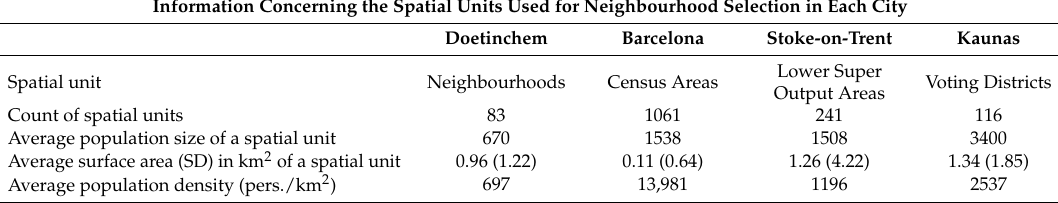
Table 1. Geographical information about the four PHENOTYPE cities and their